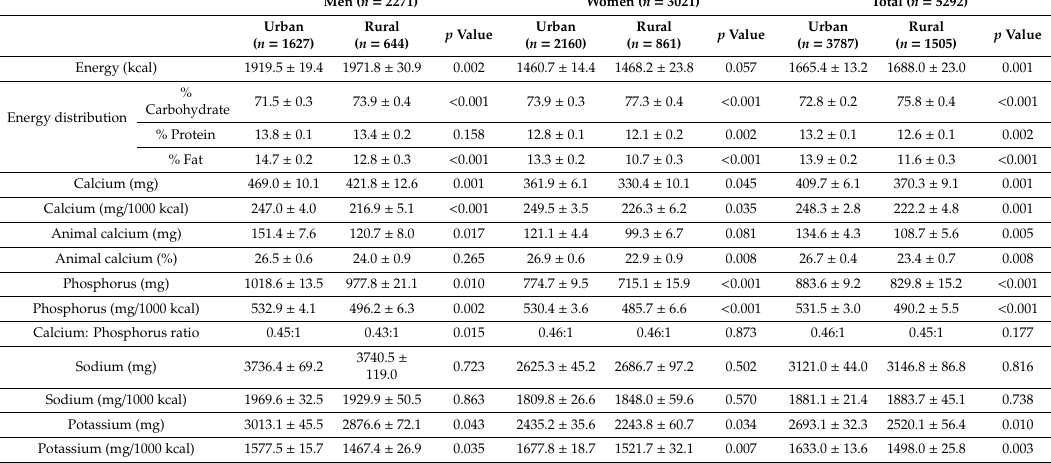
Table 3. Daily energy, macronutrient, and mineral intake levels of rural and urban Korean